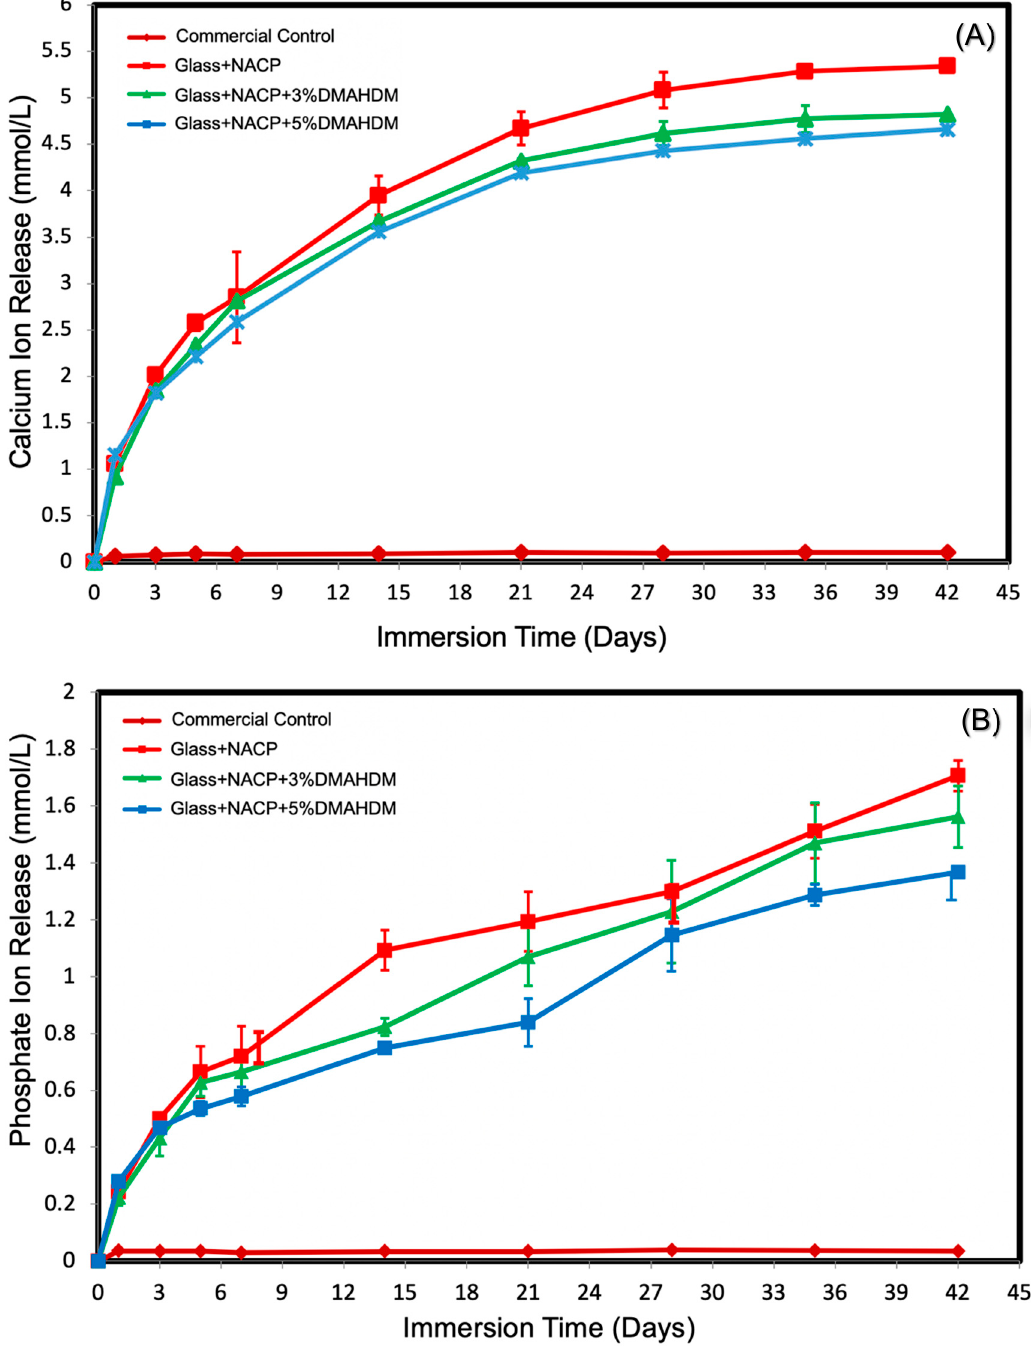
Figure 5. Initial ion release from the virgin cement samples. ( A ) Ca 2+ ion release and ( B ) PO ₄ ³ ⁻ ion release (mean ± SD; n = 6). All tested experimental cement groups had high Ca 2+ and PO ₄ ³ ⁻ ion releases over 42 days. Increasing the DMAHDM percentage from 3% to 5% did not significantly affect Ca 2+ and PO ₄ ³ ⁻ ion release ( p < 0.05).